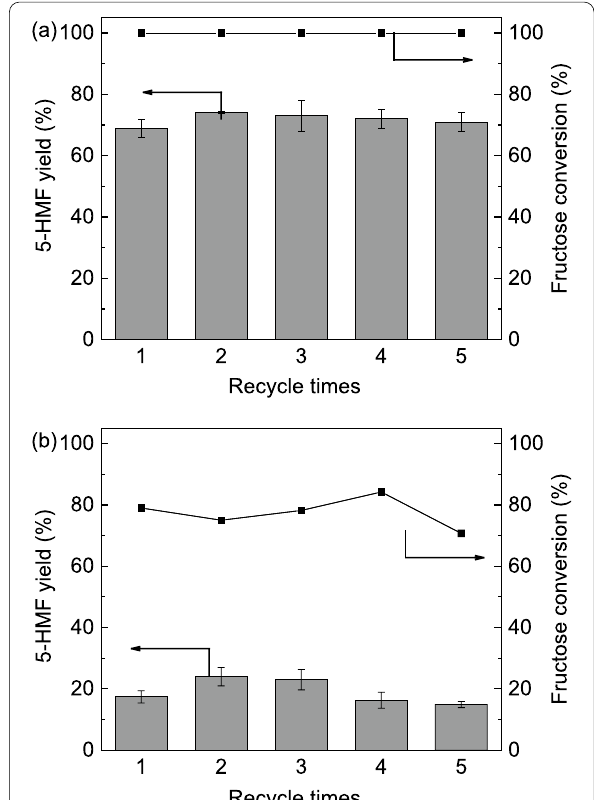
Fig. 6 Recycle of catalyst to obtained 5-hydroxymethylfurfual (5-HMF) from fructose with ( a ) HBM-400 as catalyst ( b ) humic acid as catalyst (reaction condition: 0.05 g of fructose, 2 g of [BMIM]Cl, 0.05 g of catalyst, 120 °C, 120 min reaction